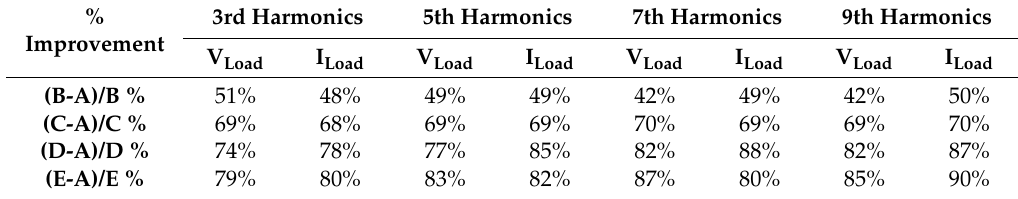
% Age Improvement in Odd Harmonics Reduction with AFBLNF-MPPT as Compared to IC-